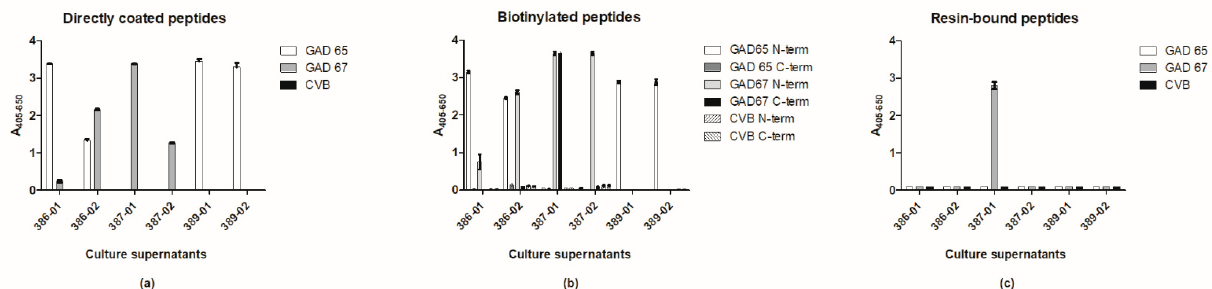
Figure 3. Antibody reactivity to glutamic acid decarboxylase (GAD) and coxsackievirus (CVB) peptides in different enzyme-linked immunosorbent assay (ELISA) setups. ( a ) Antibody reactivity to peptides coated directly to the solid surface of microtiter plates. ( b ) Antibody reactivity to biotinylated peptides tested in pre-coated streptavidin microtiter plates. ( c ) Antibody reactivity to resin-bound peptides analyzed by modified ELISA, where reactivity was determined though interaction to resin- linked peptides in membrane-containing microtiter plates, as described in the Section